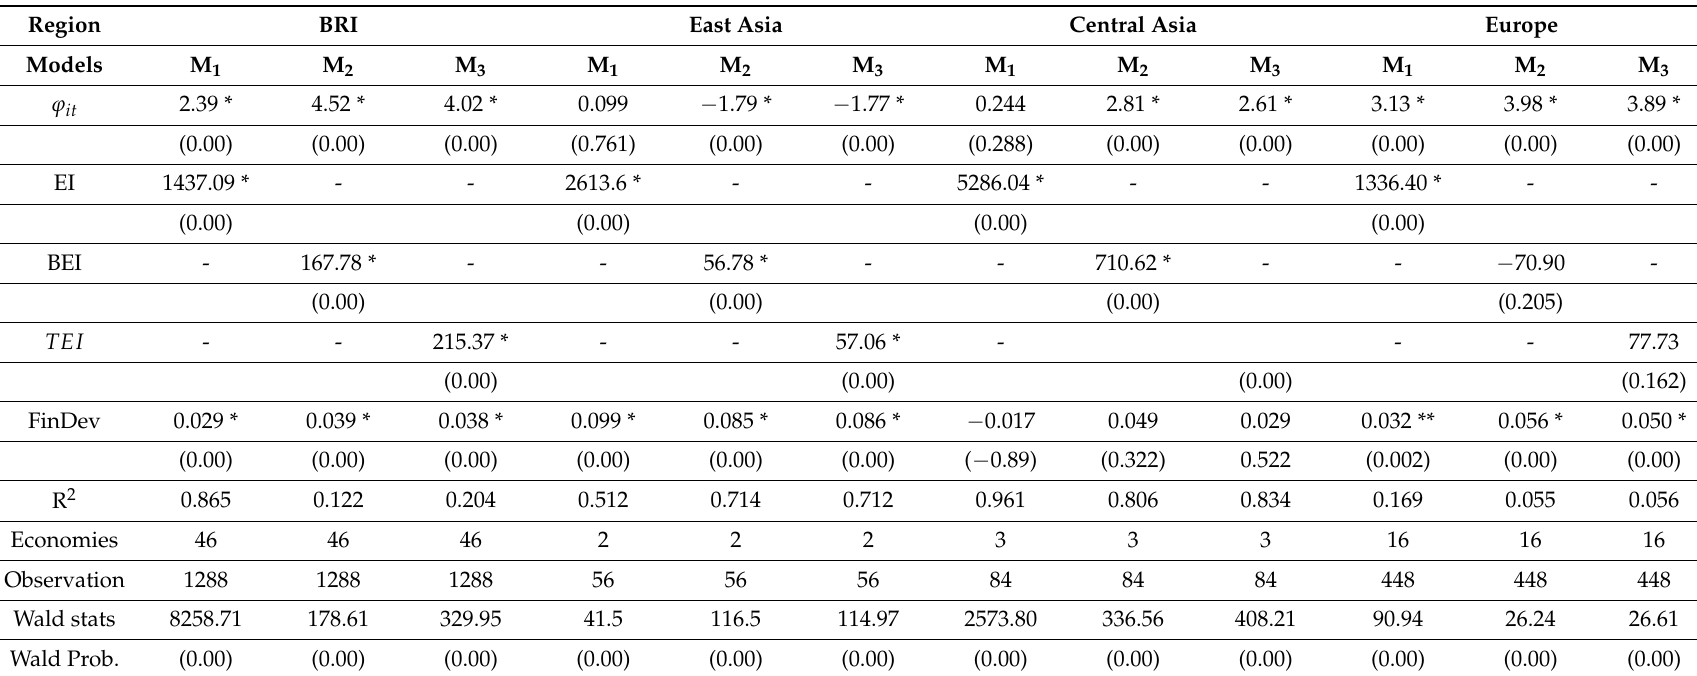
Table 5. Results of BRI Energy